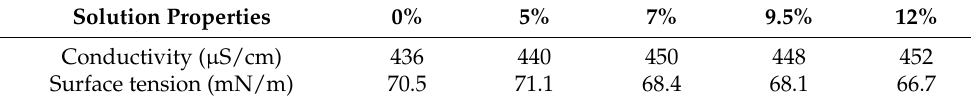
Table 1. Values of conductivity and surface tension for solutions with microparticles of CuO.